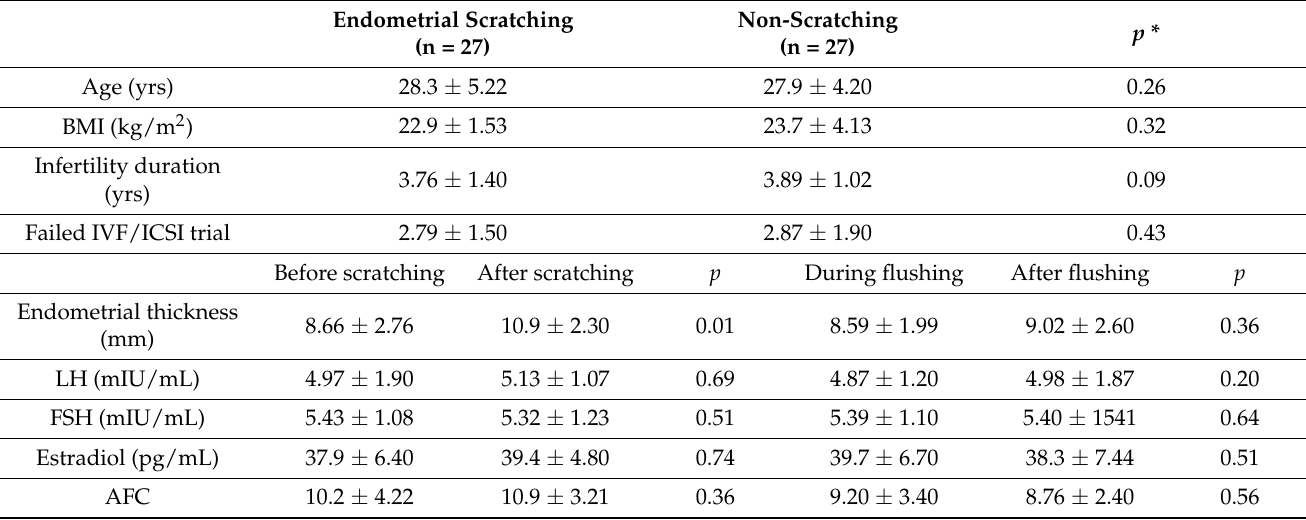
Table 1. Comparison of demographic characteristics of the scratching and sham